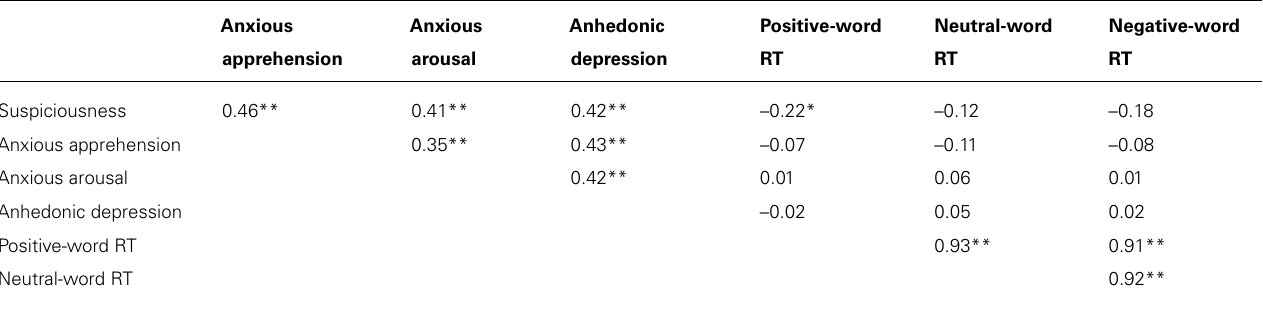
Table 2 | Correlations among suspiciousness, anxiety, and depression measures and behavioral performance on the emotion-word Stroop